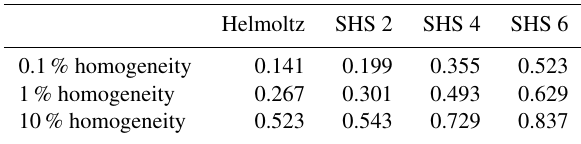
Figure 1. Current density distribution of spherical coils oriented along e ϕ in spherical coordinates. Table 1. Axisymmetric coil homogeneity study: comparison be- tween several coil configurations: Helmholtz, SHS 2, SHS 4 and SHS